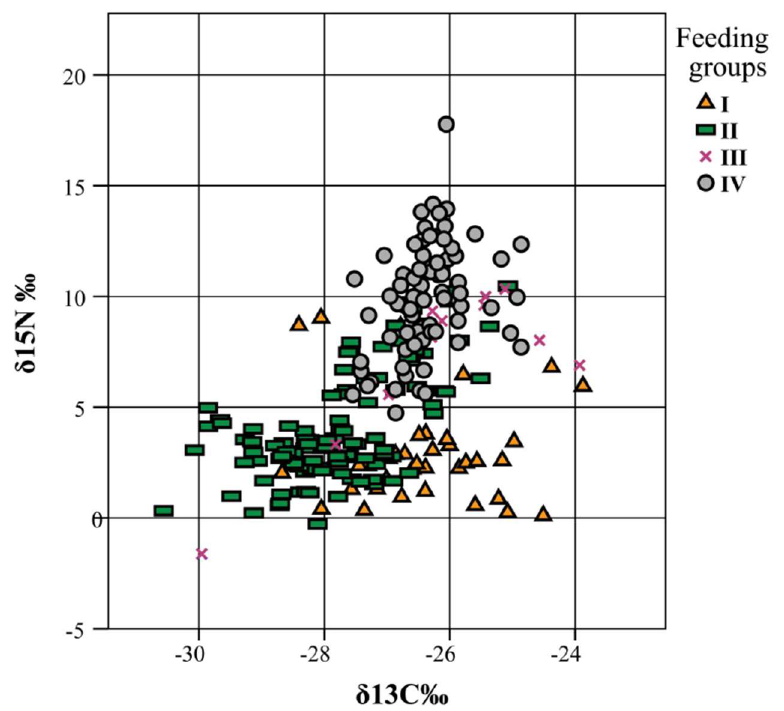
Figure A2. Scatterplot between δ 15 N and δ 13 C. Symbols: Orange square: feeding group I; green circle: feeding group II; purple circle: feeding group III; black circle: feeding group IV.